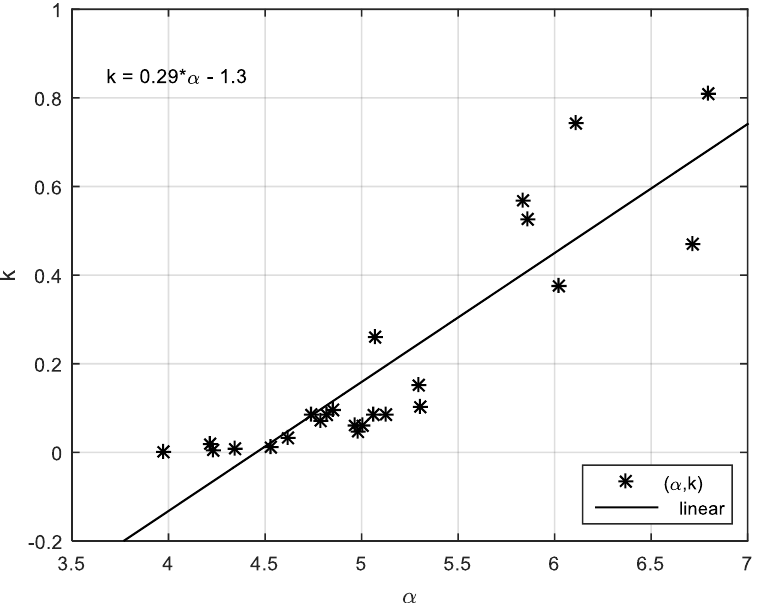
Figure 6. Linear correlation between the model parameters 𝛼 and